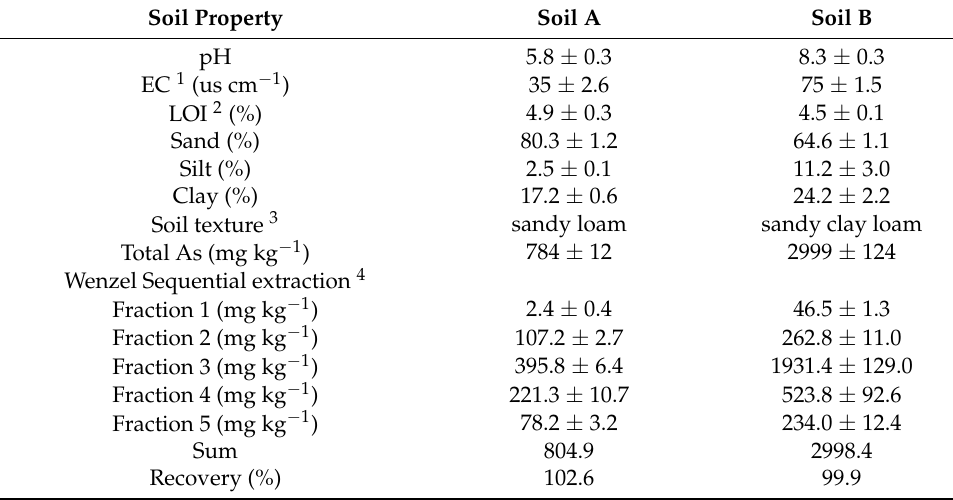
Table 1. Physico-chemical properties of experiment